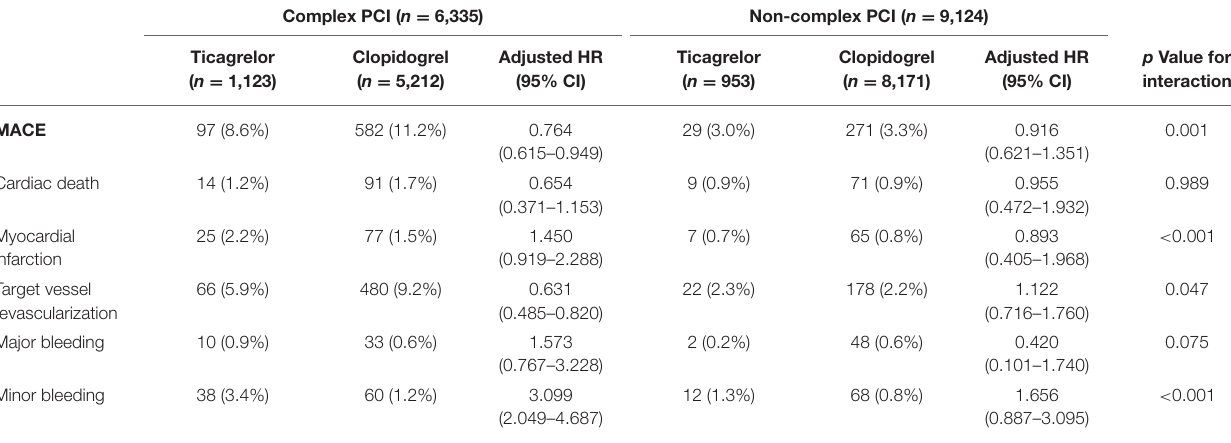
TABLE 4 | Clinical outcomes at 1 year of patients treated with ticagrelor vs. clopidogrel in complex and non-complex PCI